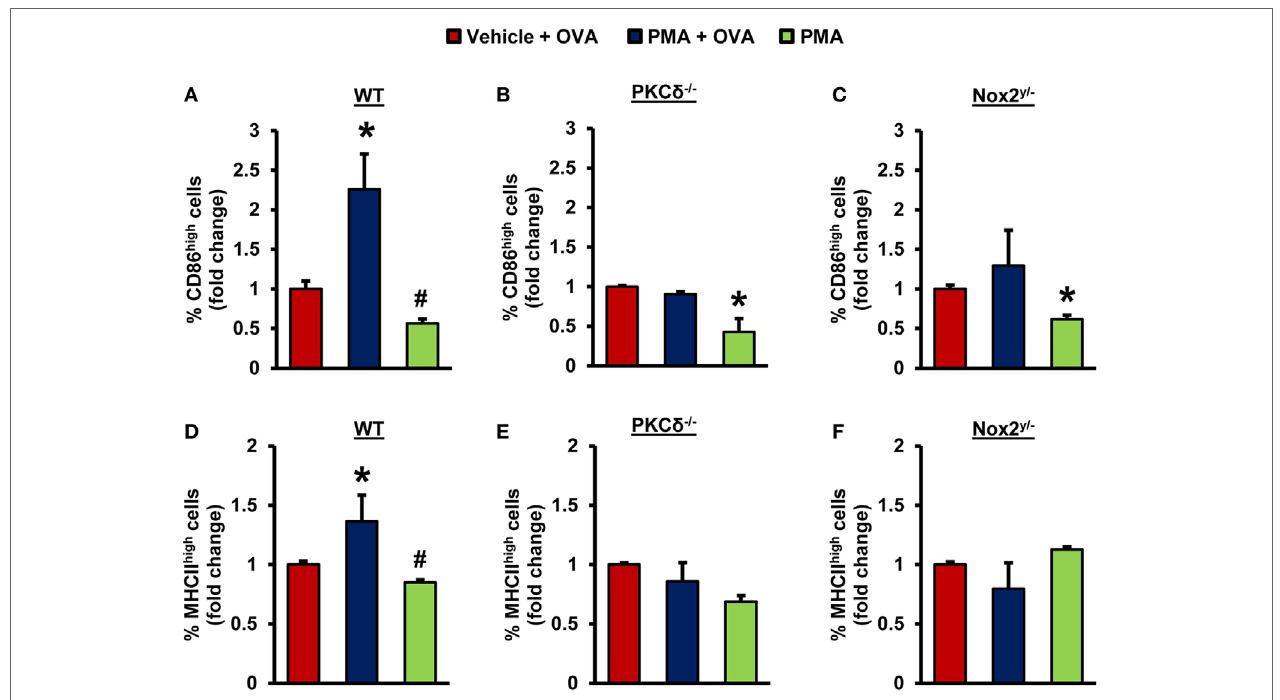
FigUre 4 | PKC δ - and Nox2-mediated antigen macropinocytosis stimulates maturation of iDCs. WT (C57BL/6J), PKC δ − / − , and Nox2 y/ − BMiDCs were treated with vehicle + unlabeled OVA (50 µg/mL), PMA (1 µM) + OVA, or PMA alone for 24 h. FACS analysis was performed to determine CD86 (a–c) and MHCII (D–F) expression in CD11c + iDCs. Bar graphs show fold changes in the percentage of CD86 high /MHCII high cells compared to “vehicle + OVA” treatment ( n = 3). Data represent the mean ± SD. * p < 0.05 vs. vehicle + OVA, # p < 0.05 vs. PMA +